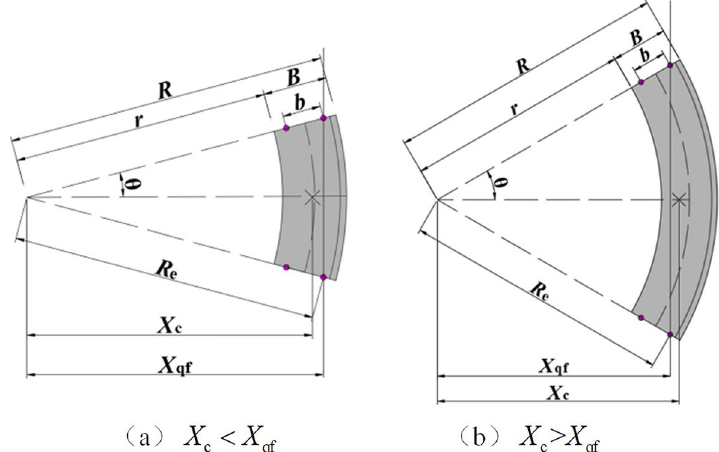
Fig. 21 Barycentre position of curved